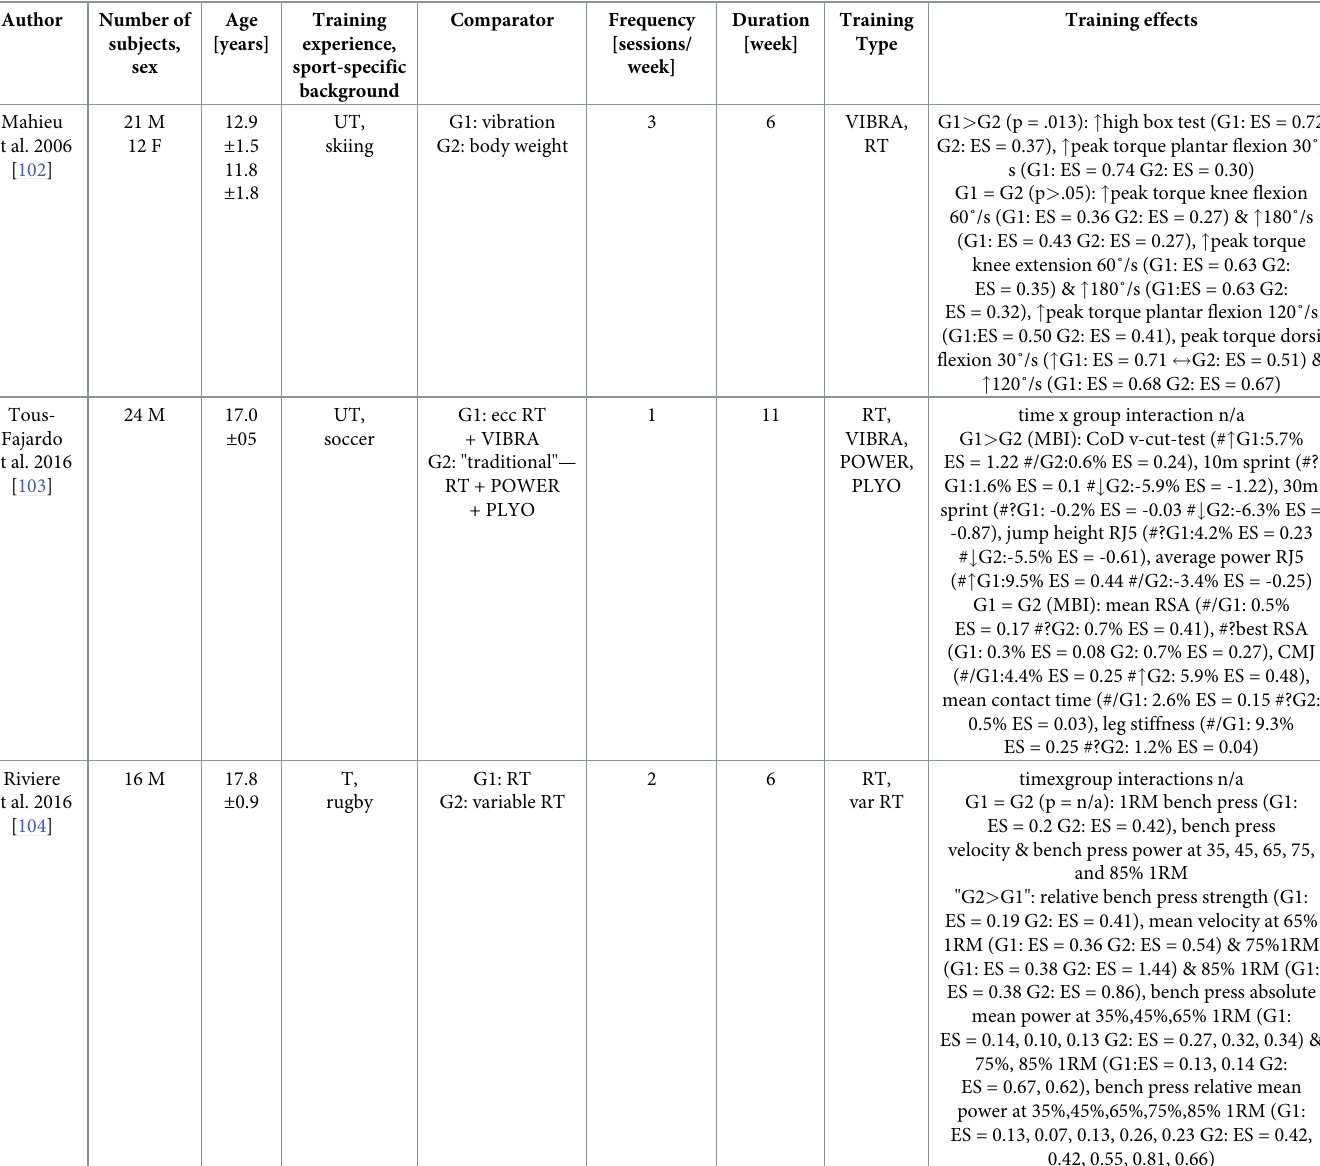
Table 13. Influence of alternative resistance training methods on components of physical